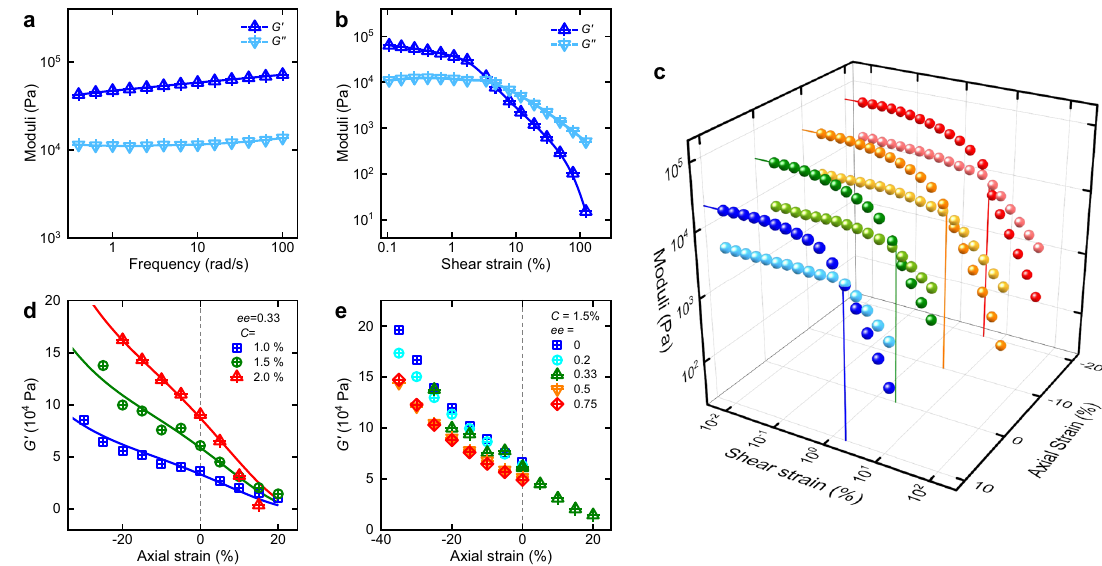
Fig. 3 Shear and biaxial responses of astral hydrogels. a , b Routine shear rheology at zero axial strain for a representative astral gel ( C = 1.5 wt% and ee = 0.33) with a frequency sweep ( a shear strain fi xed at 0.1%) and shear strain sweep ( b frequency fi xed at 10 rad/s). c A 3D plot of moduli-shear strain curves under different axial strains (gel composition: C = 1 wt% and ee = 0.33). The dark and light color spheres denote G ′ and G ″ ; droplines to the left wall highlight elasticity in the linear regime and droplines to the bottom wall indicate yield points. d , e Dependence of shear elasticity on axial strains for different concentrations ( d solid lines are obtained by vertically rescaling the global fi tting in Fig. 5a) and various ee ( e ).